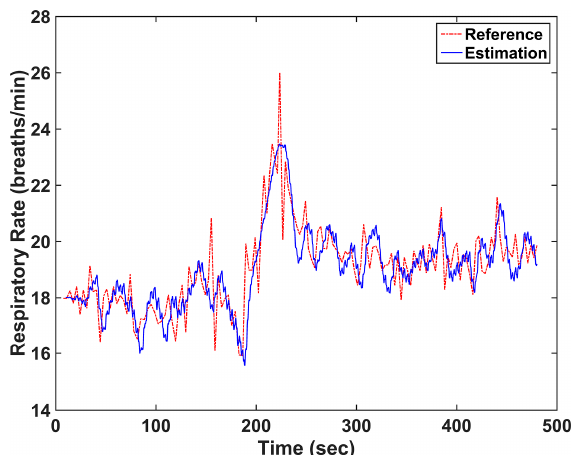
Figure 2. An example of a respiratory rate (RR) estimation of the 8 min data. The solid line is the RR estimated using the proposed method and the dash-dot line is the reference RR. The resultant root mean square error (RMSE) value was 0.7381 breaths/min.